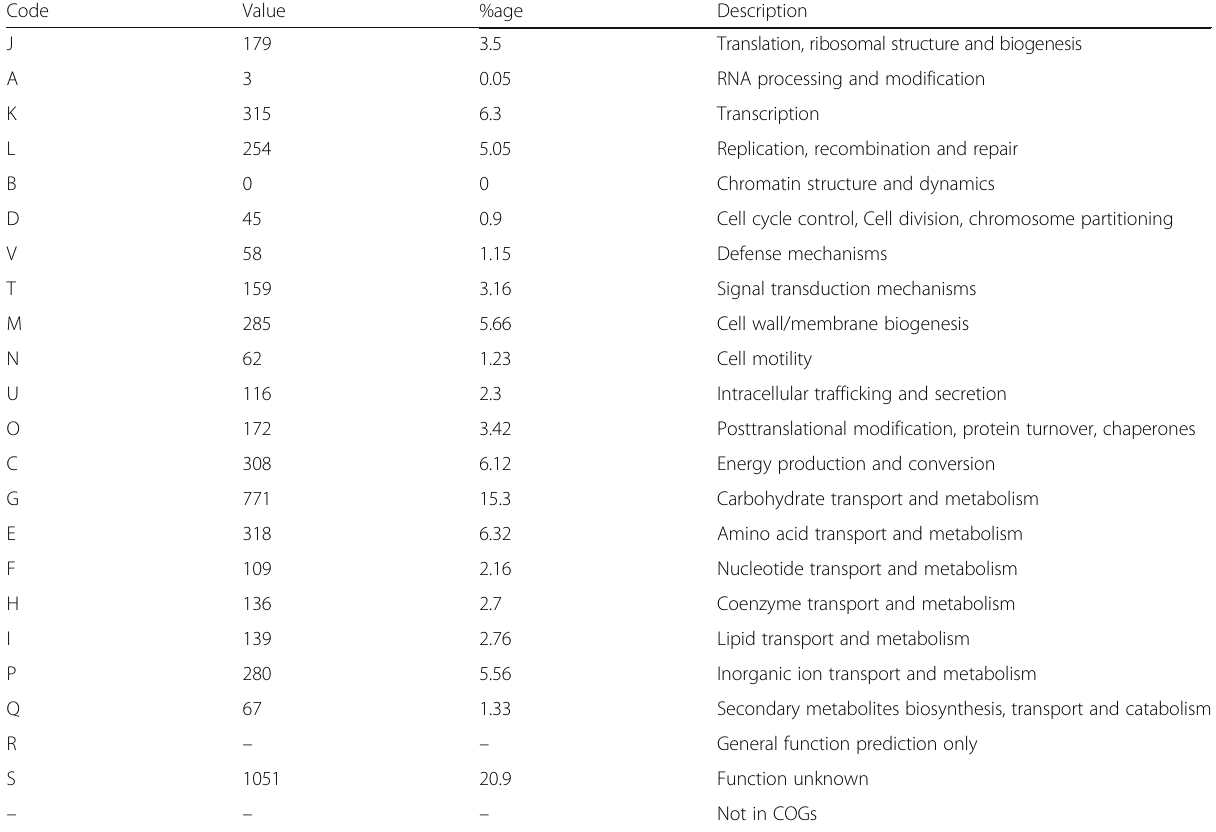
Table 5 Number of genes associated with general COG functional